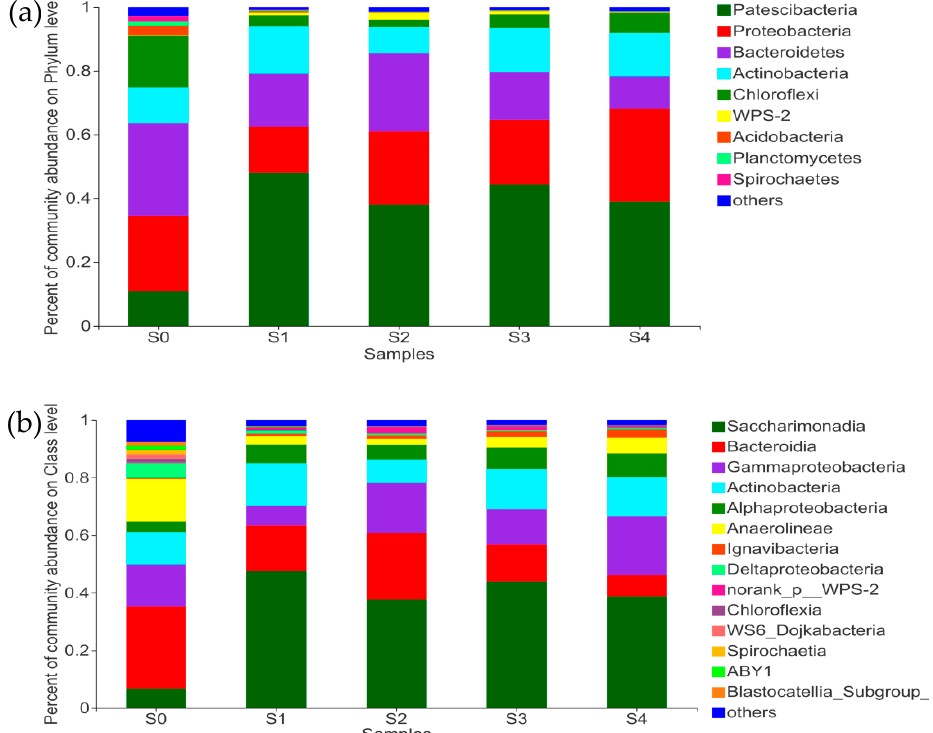
Figure 5. Microbial community structures of five samples (seed sludge, S0; C / N = 4.64, S1; C / N = 3.87, S2; C / N = 2.32, S3; C / N = 0.77, S4) at the phylum ( a ) and class ( b ) level (bacteria whose relative abundance were less than 1% were merged into others).